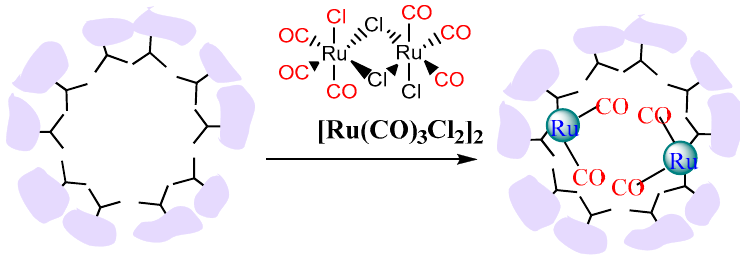
Figure 16. The recombinant L ‐ chain apoferritin (apo ‐ rHLFr) of Ru carbonyl complexes.